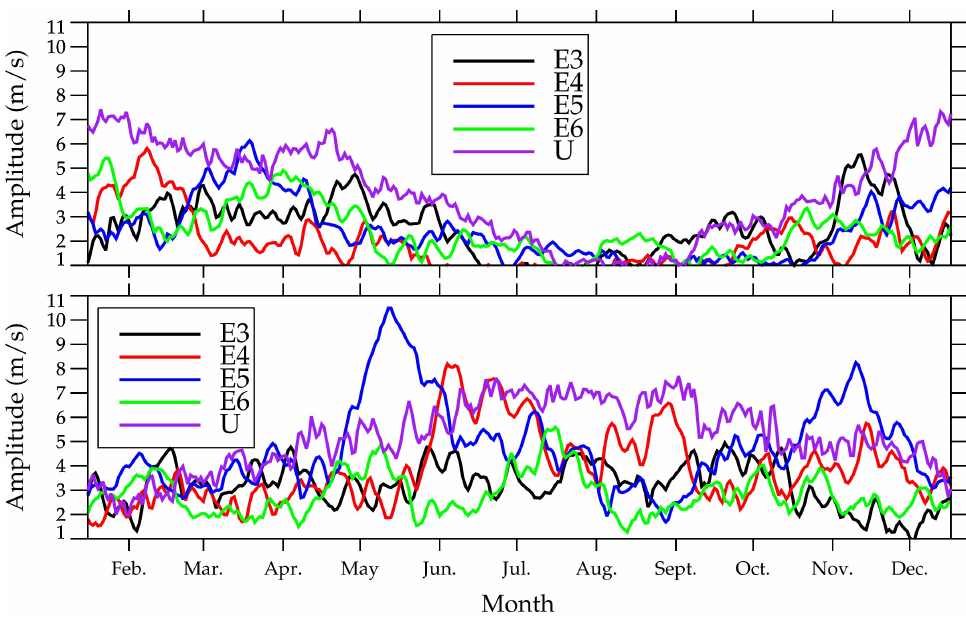
Figure 7. Zonal wind amplitudes of the 10-day eastward-propagating modes with zonal wavenumber 3 to 6 at ∼ 11 km deduced from the MERRA-2 data at 32 ◦ N ( top row ) and 32 ◦ S ( bottom row ) in 2020. A purple line marks the eastward zonal-mean zonal wind. Table 1. The correlation coefficients between the E3/E4/E5/E6 10DWs and the zonal-mean zonal